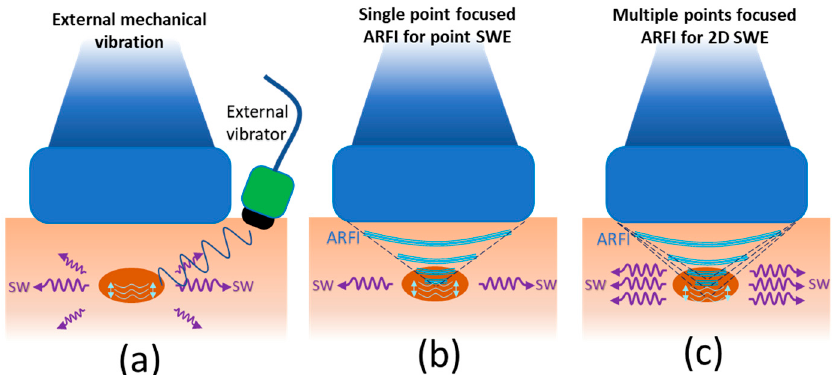
Figure 7. Shear wave elastography (SWE) techniques categorized by their excitation methods to generate shear waves in the tissue of interest: ( a ) external mechanical vibration, ( b ) single-point- focused ARFI for point SWE, and ( c ) multiple-point-focused ARFI for 2D SWE.